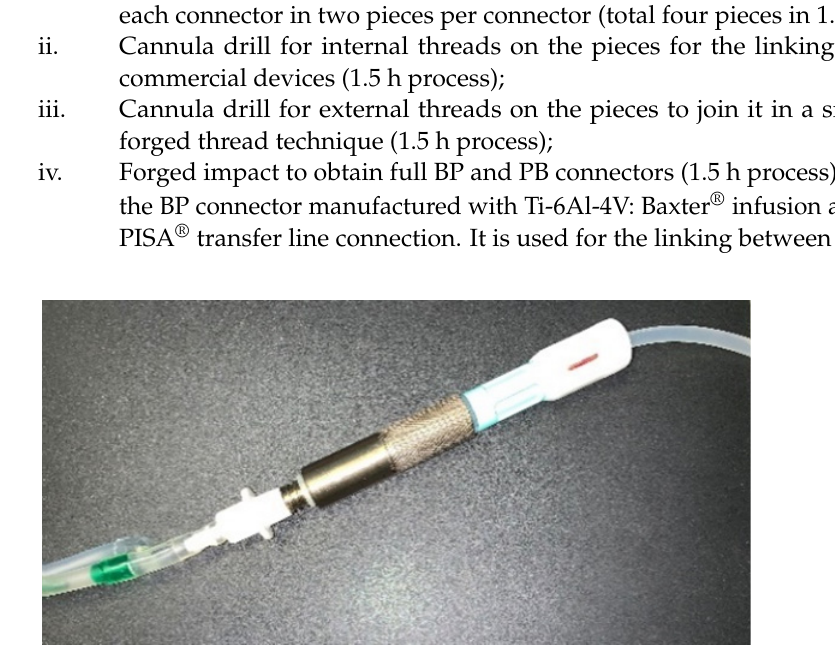
Figure 8. BP connector manufactured in titanium with branded equipment.